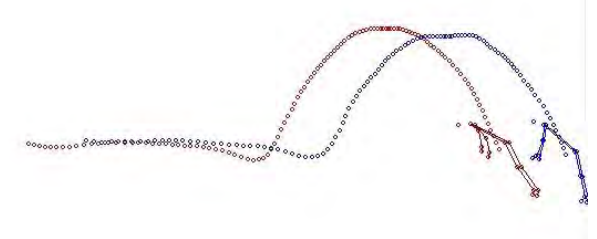
Fig. 7. Phase of finalizing movements with grouped back double somersault after rondat (tested A, variant 1, time 1. 750 sec.) and arched back double somersault after rondat – back turnover (tested B, variant 2, time 1. 683sec.) Body postures on support precede key element FP, i.e. posture of balanced landing (half squatting with forward half bent, arms